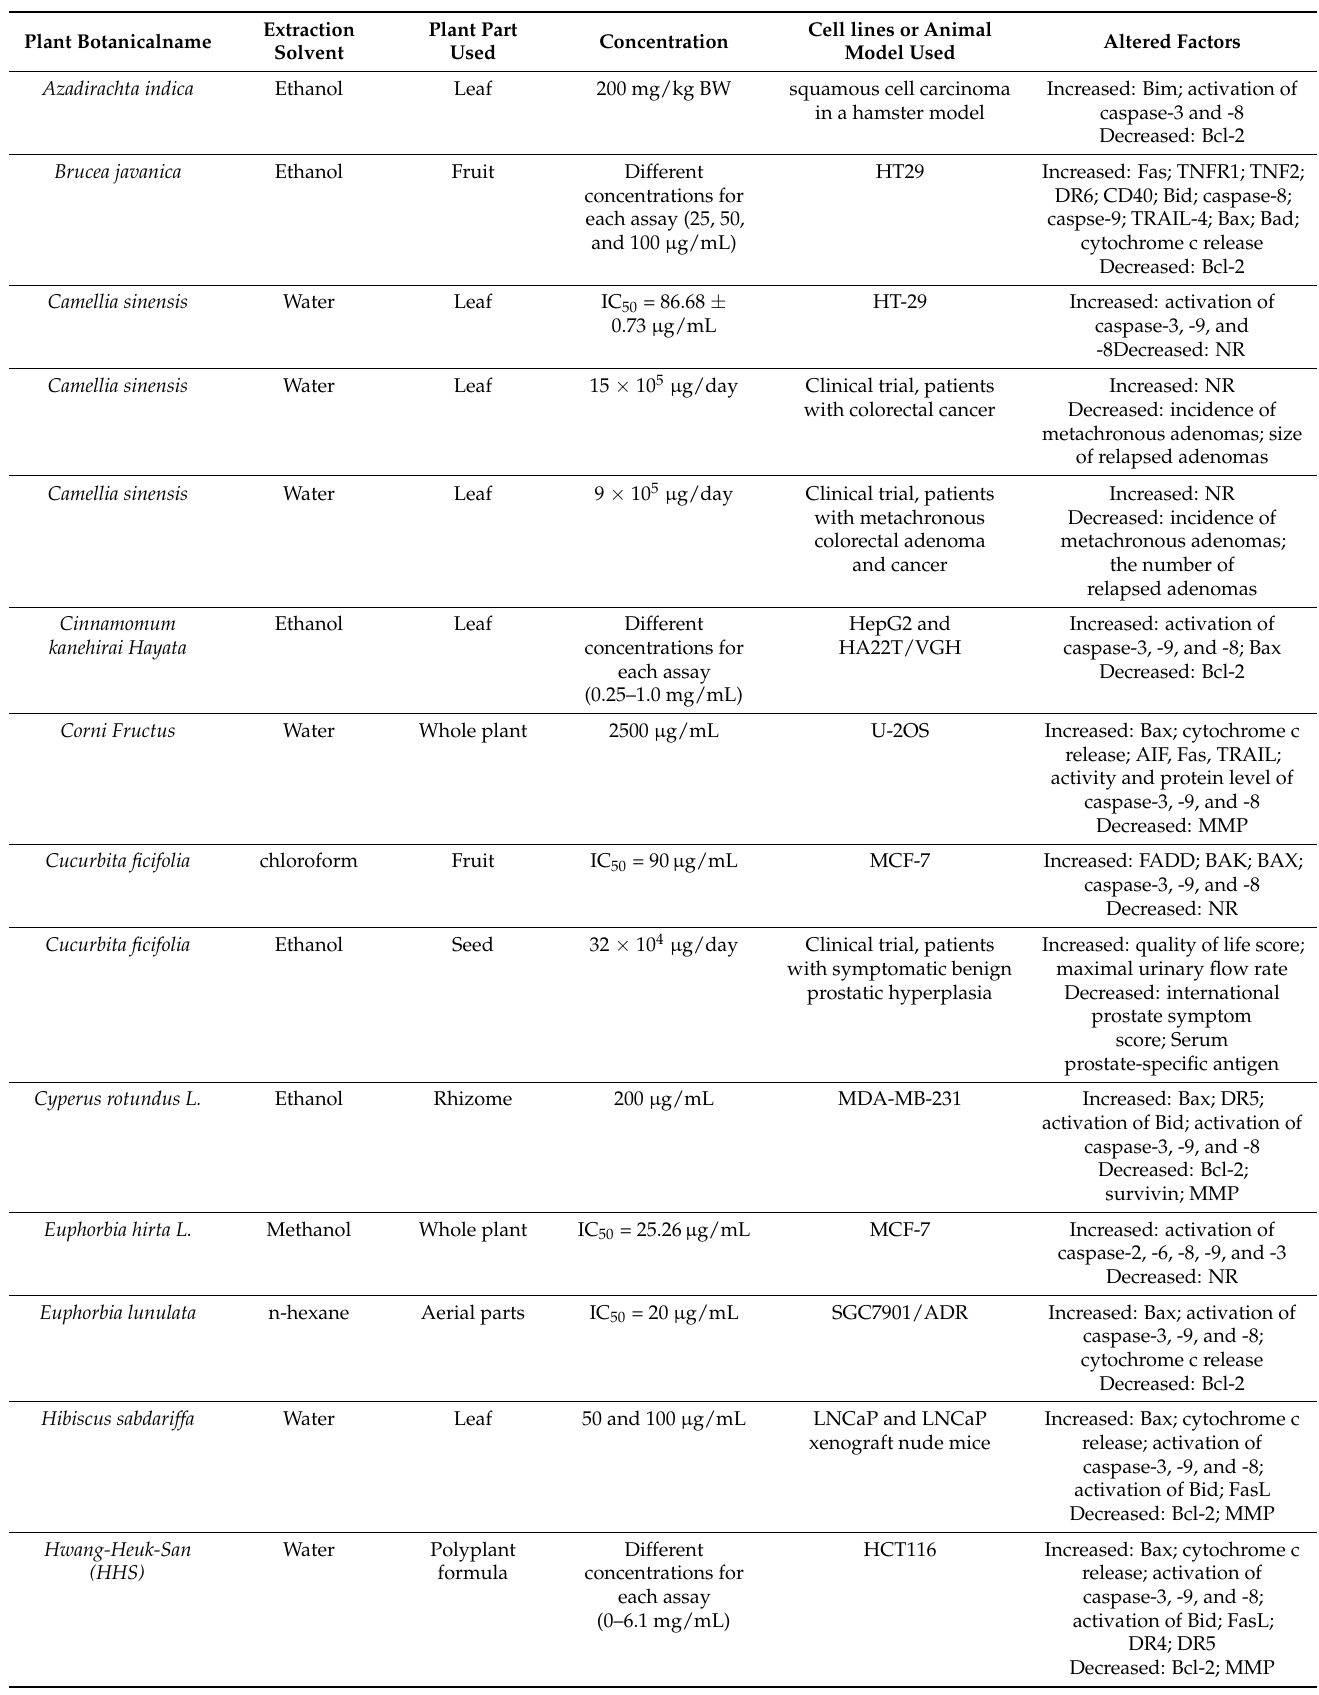
Table 1. Plant extracts with the capacity to trigger both pathways of